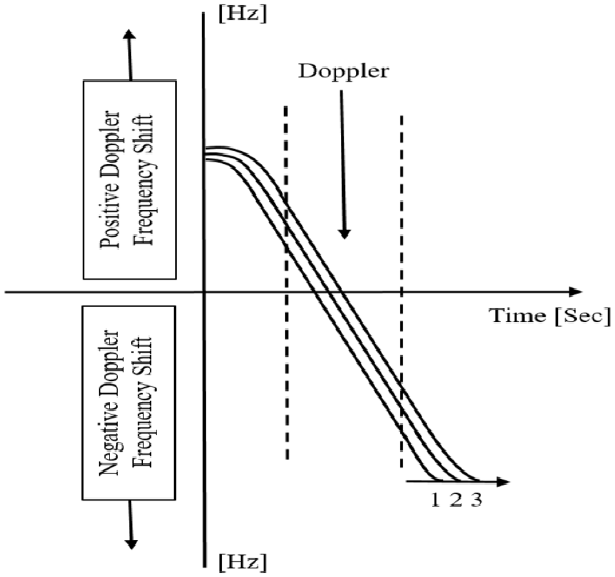
Figure 1. Propagation path of an ultrasonic wave due to Doppler Effect. Autonomous vehicle localization involves different sensors, including vision sensors (cameras), LIDAR, RADAR, ultrasonic sensors, GPS/GNN, and more. Advanced Driver Assistance Systems (ADAS) rely on various sensors to function correctly, but these sensors can experience malfunctions that cause them to fail. For example, cameras can be affected by lens occlusion, environmental conditions, or faults in the optics. Incorrect data readings, electrical issues, or optical misalignment can cause LIDAR failures. RADAR failures can occur due to cyberattacks or environmental factors. GPS/GNN faults can happen due to issues with the receiver, clock, or satellite broadcast